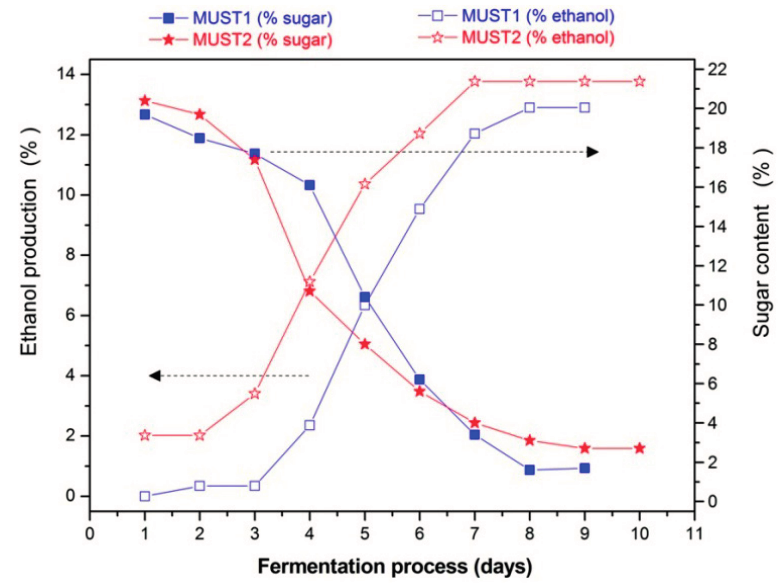
Figure 3. The evolution for the two different fermentation processes over time after daily chemical analysis in terms of sugar consumption and ethanol production.